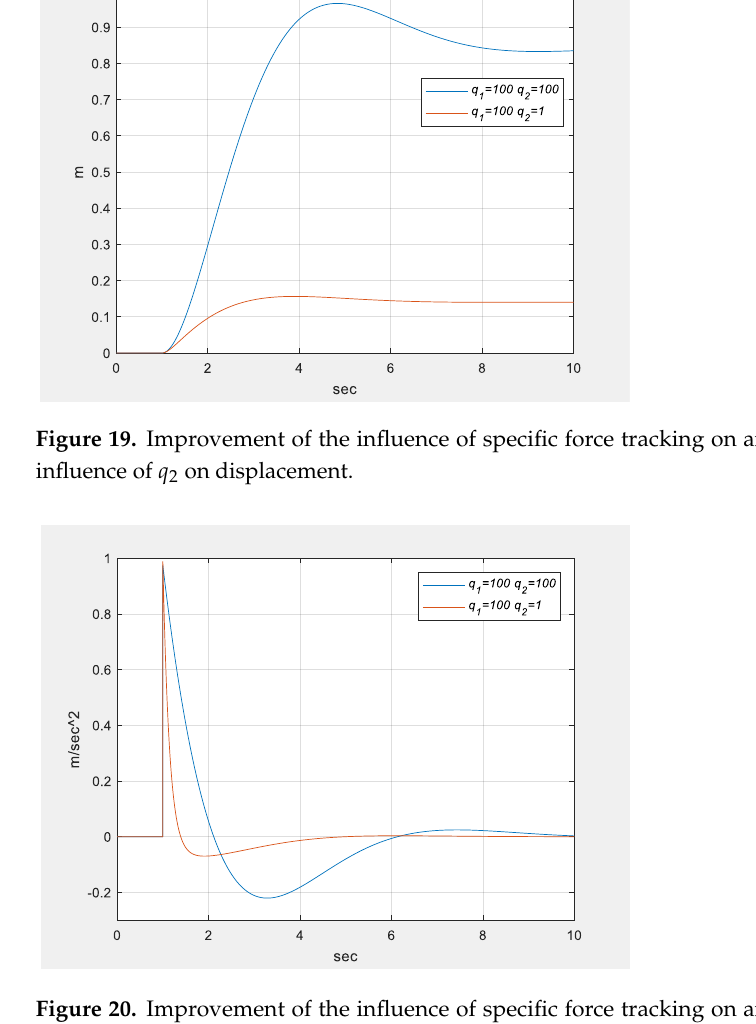
Figure 20. Improvement of the influence of specific force tracking on angular velocity influence of q 2 on acceleration a x .